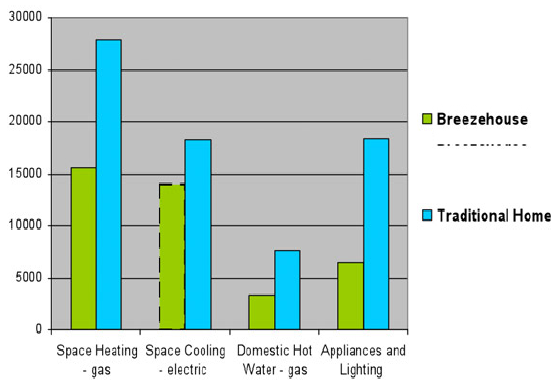
Figure 4: Breezehouse sustainability rating (Kaufmann and Remick